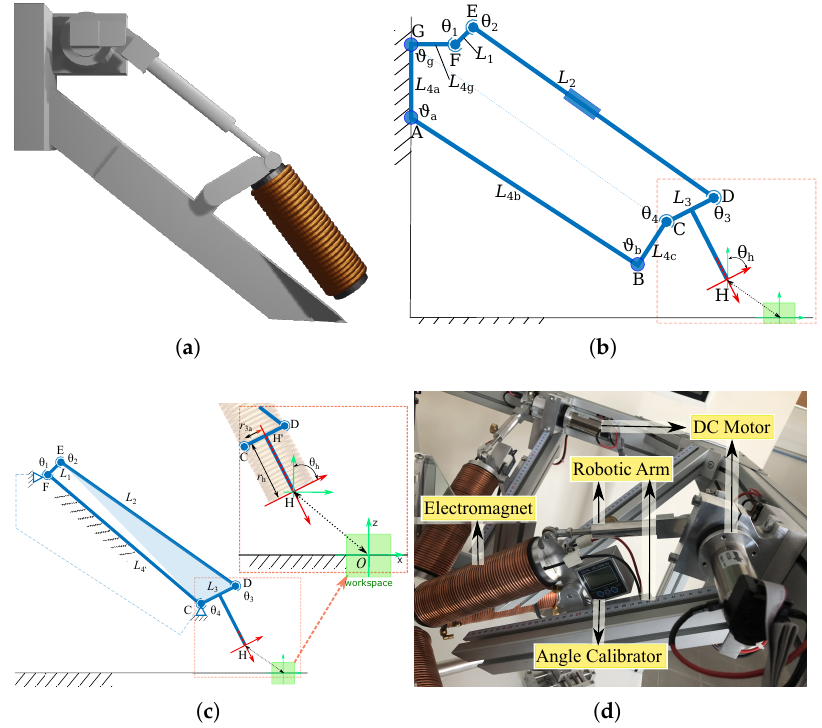
Figure 12. Representation of the robotic arm: ( a ) CAD illustration of the concept, ( b , c ) the kinematics chain with the four links L 1 – L 4 and joints θ 1 – θ 4 and ( d ) the realized 1-DOF robotic